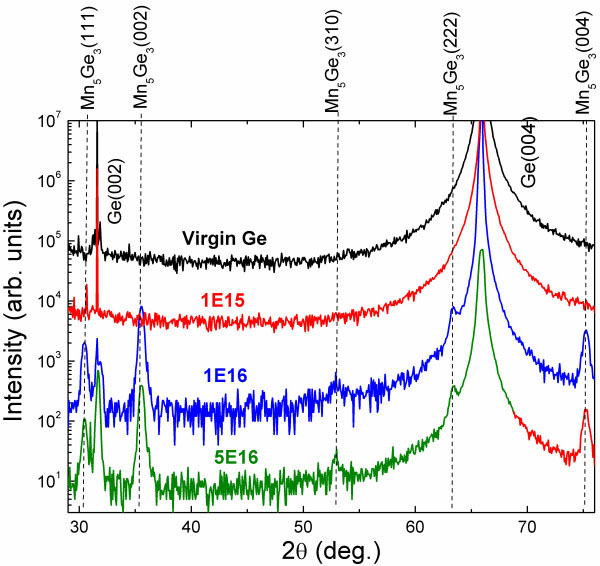
XRD 2θ-θ scans revealing the formation of Mn5Ge3nanomagnets. Beside the main peaks from Ge(004), the diffraction peaks of Mn5Ge3(111), (002), (310), (222), and (004) are clearly visible.